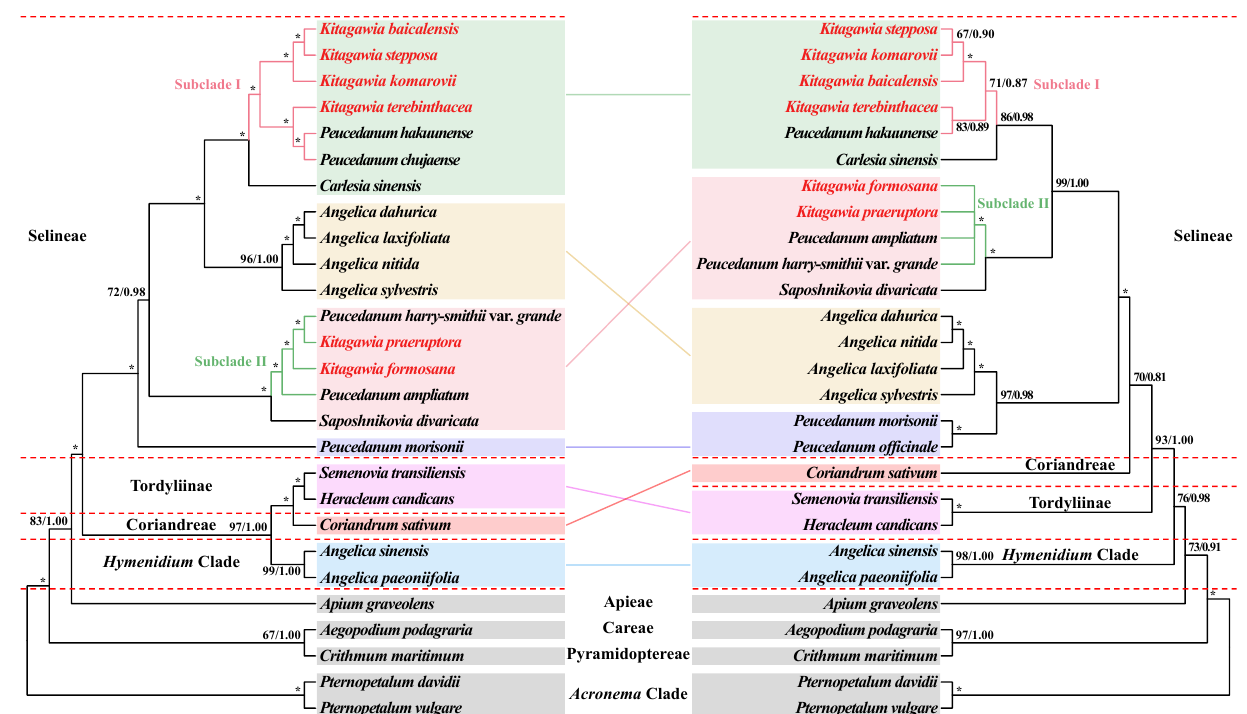
Figure 1. Phylogenetic trees constructed by maximum likelihood (ML) and Bayesian inference (BI). The bootstrap values (BS) of ML and posterior probabilities (PP) of BI are listed at each node. (*) represents maximum support in both analyses. Colored blocks indicate the main clades or branches with inconsistent phylogenetic placements in both phylogenetic trees. ( Left ): CDS tree; ( Right ): nrDNA (ITS + ETS)